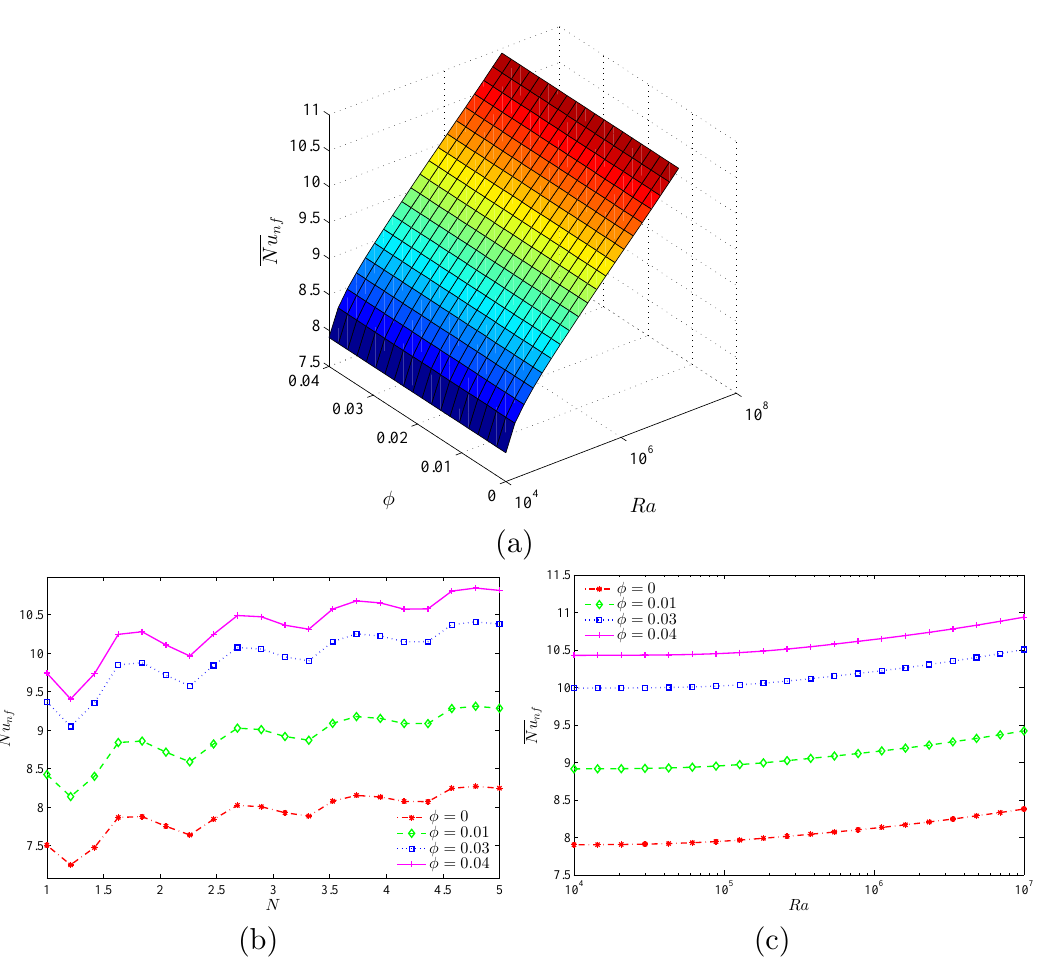
Figure 16. ( a ) 3D-plot of the average Nusselt number with Ra and φ , ( b ) variation of the average Nusselt number with N for different φ , and ( c ) variation of the average Nusselt number with Ra for different φ at N = 4 and A =